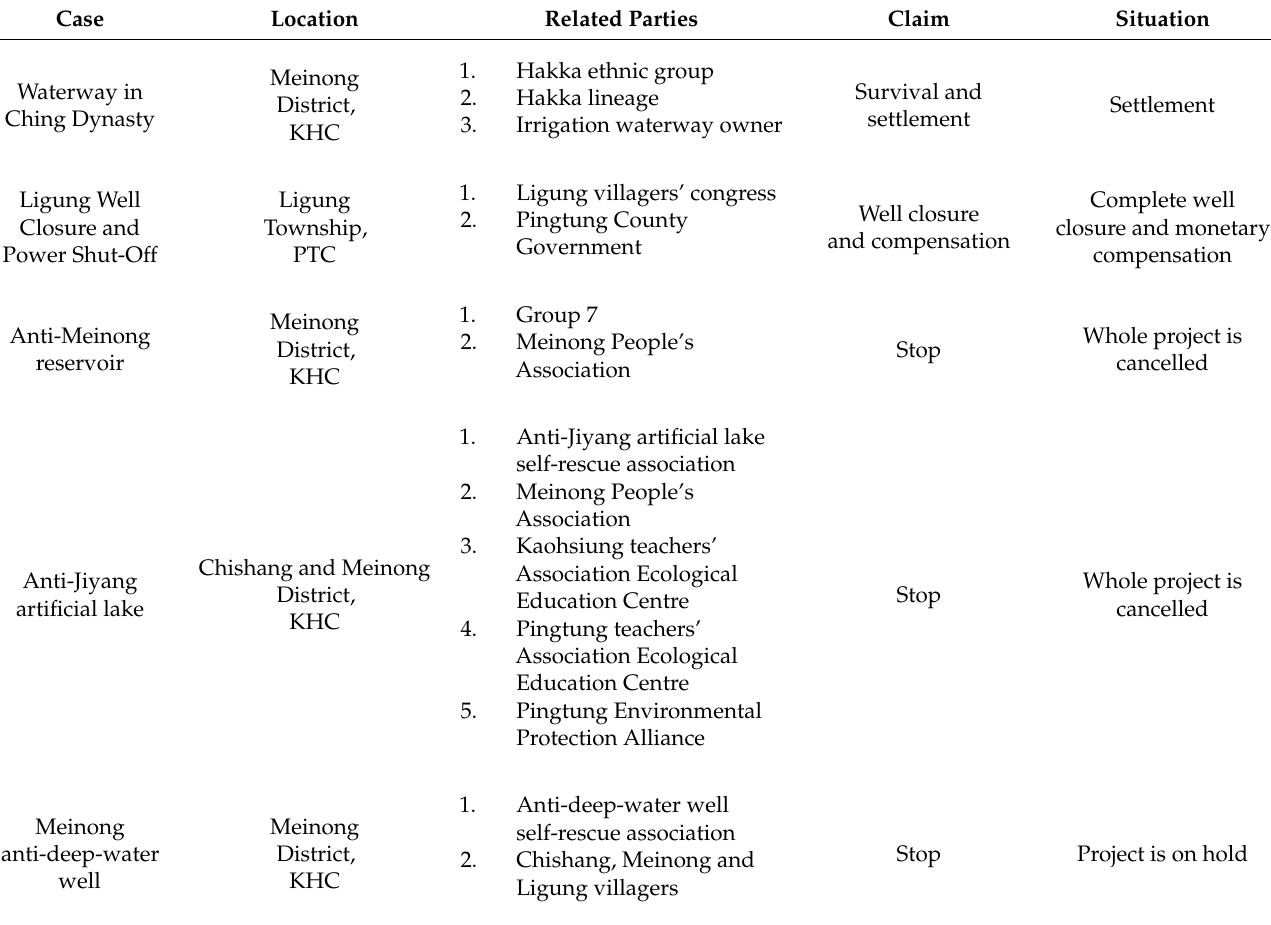
Table 2. Basic descriptions of five study